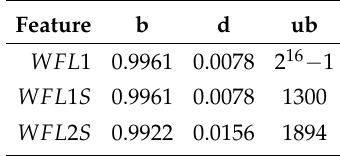
Table 4. Parameters of WFL implementations.